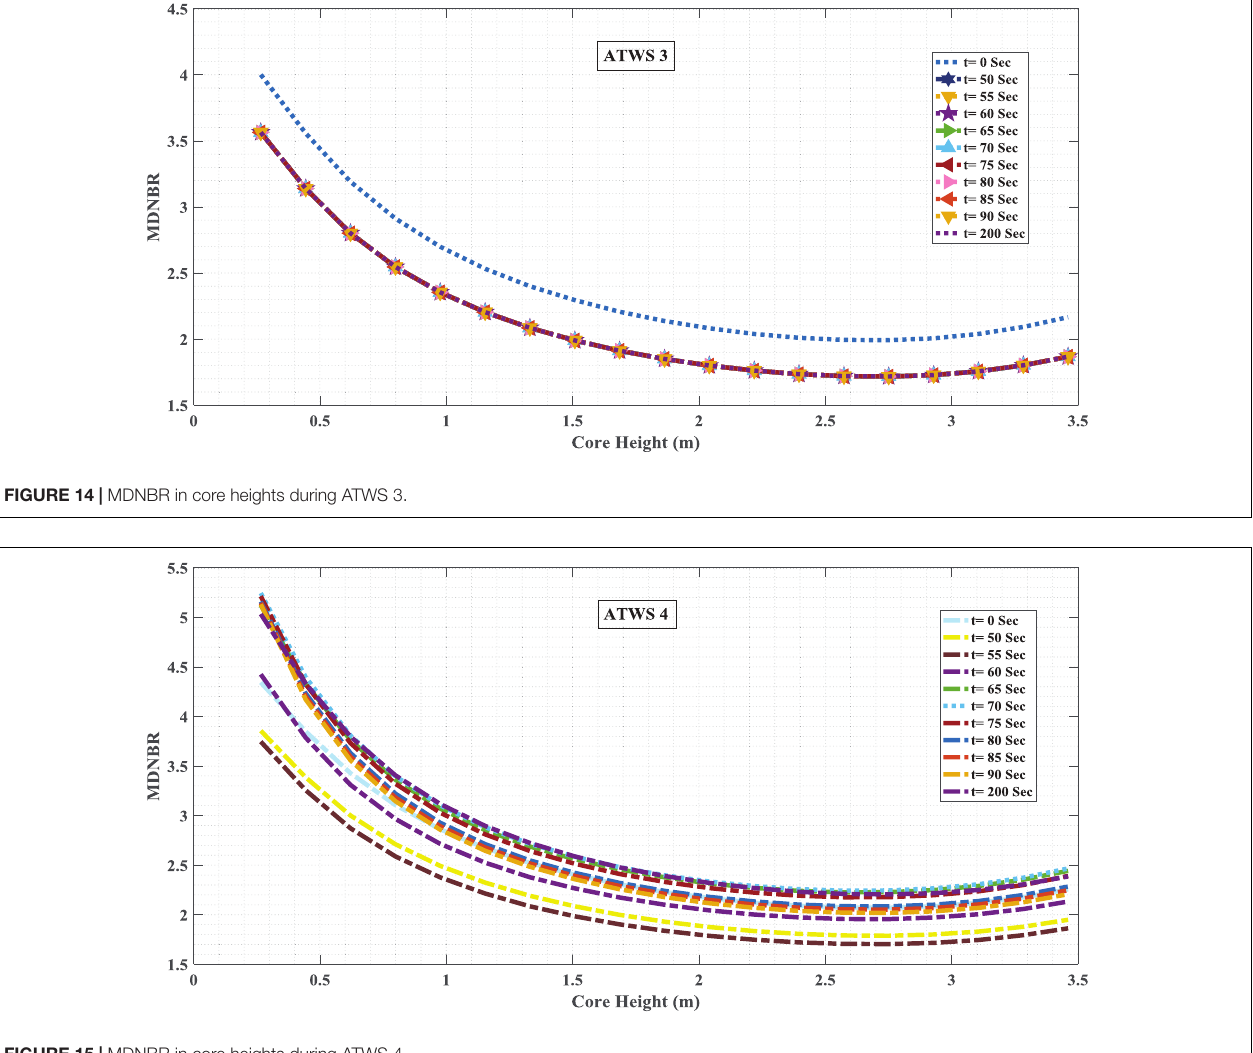
FIGURE 15 | MDNBR in core heights during ATWS